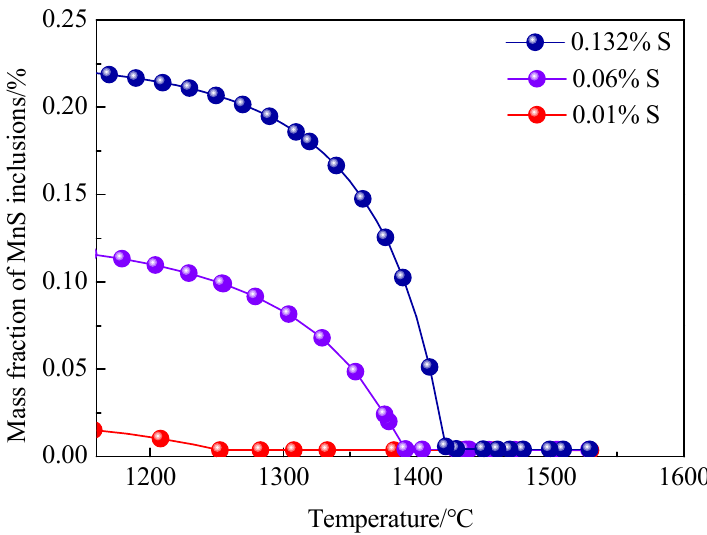
Figure 12. Thermodynamic calculation of MnS inclusion formation during solidification process by